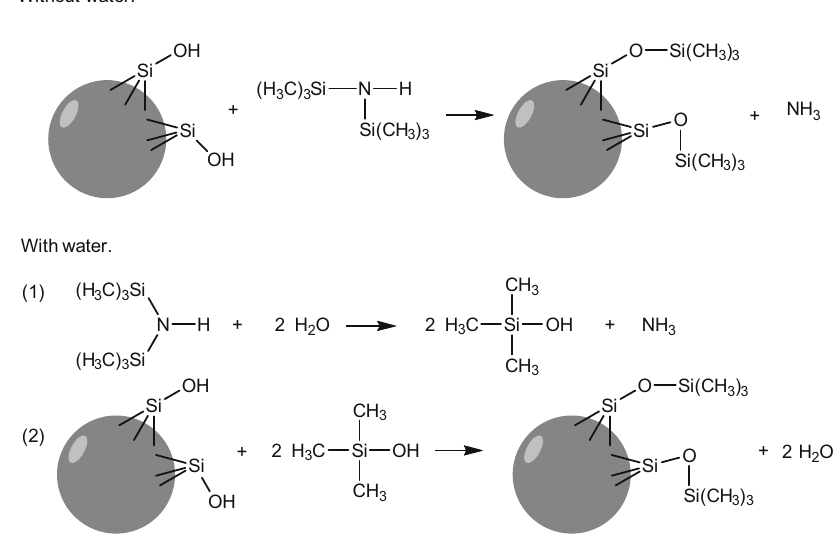
Figure 2: Reaction between silanol on surface of silica and HMDS.